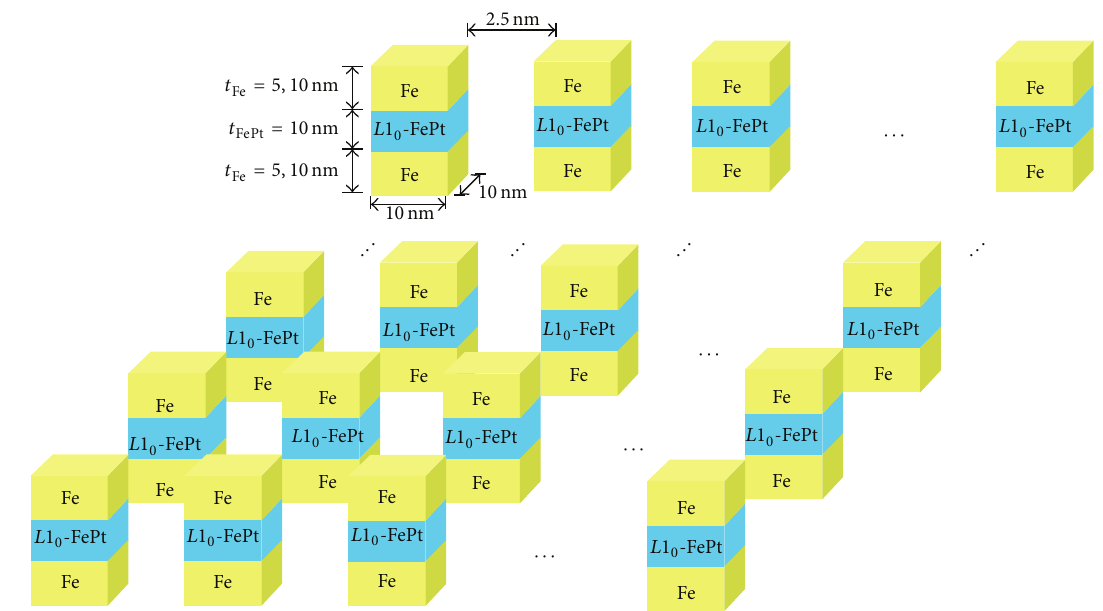
Figure 1: Structures of the proposed ECC-BPM trilayer: Fe/ L 1 0 -FePt/Fe with 400 dots at areal density over 4Tb/in 2 .